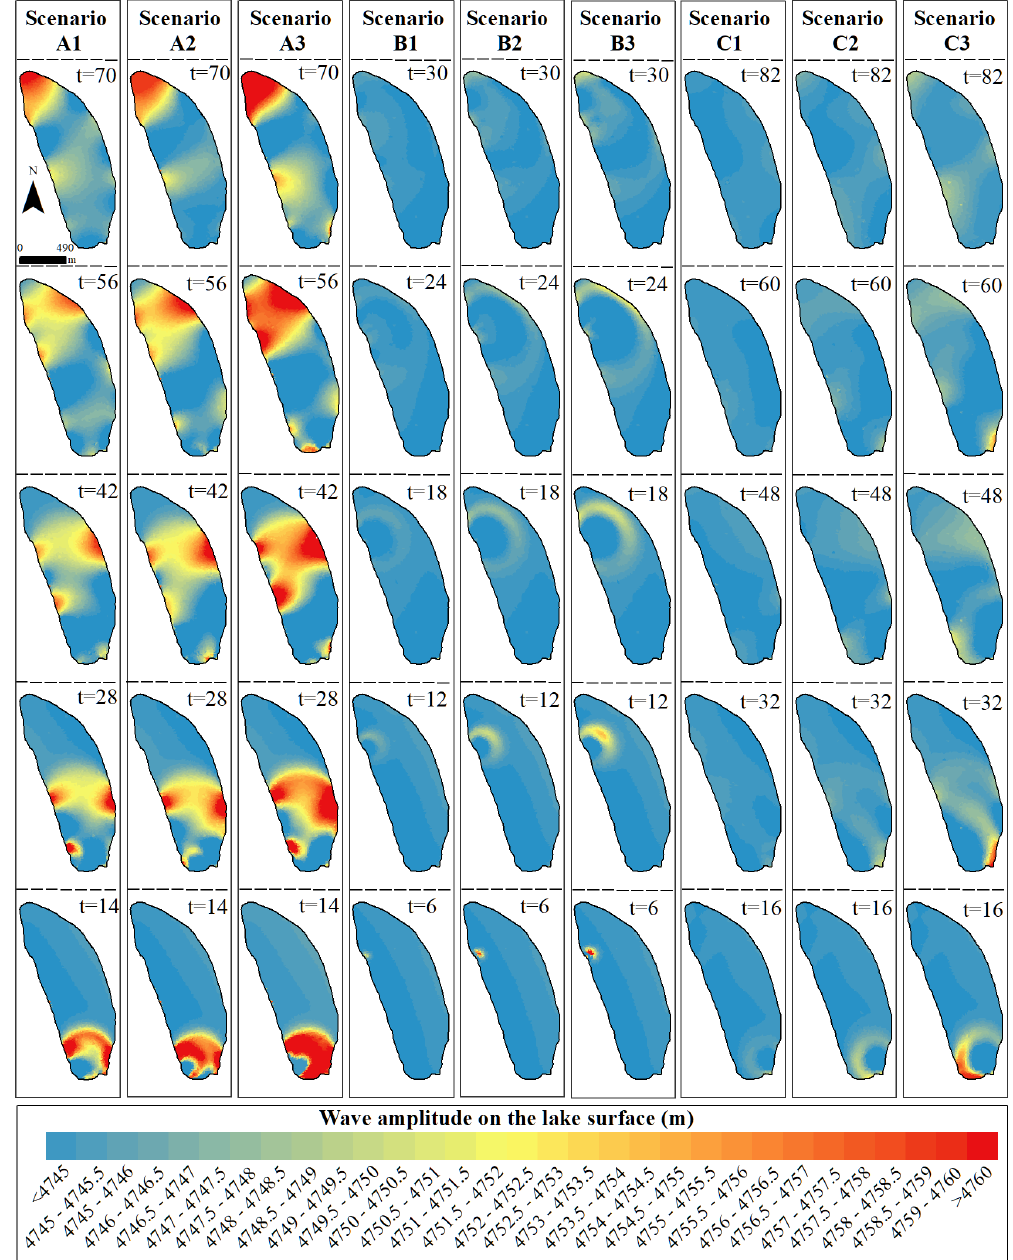
Figure 8. Propagation of displacement waves in the lake for different ice avalanche and landslide